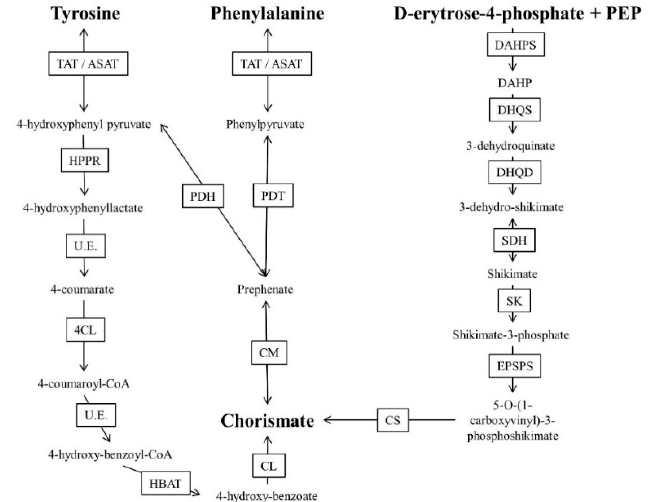
Figure 2. Scheme of chorismate synthesis from aromatic amino acids (tyrosine and phenylalanine) or the shikimate pathway. DAHP; PEP; TAT/ASAT (EC 2.6.1.5); HRPR (EC 1.1.1.237); U.E. (uncharacterized enzyme); 4CL (EC 6.2.1.12); HBAT (EC 3.1.2.23); CL (EC 4.1.3.40); PDH (EC